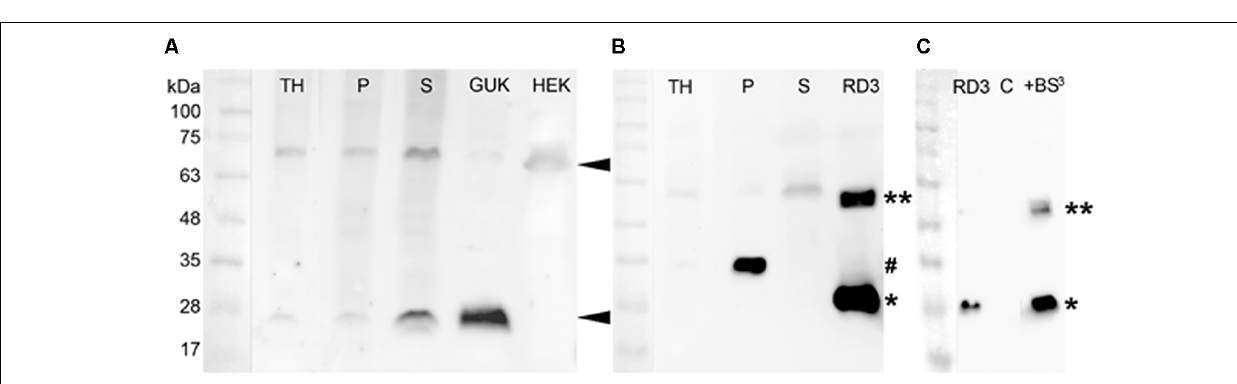
FIGURE 4 | Detection of GUK and RD3 in mouse retina tissue by specific antibodies and RD3 crosslinking. (A) Primary anti-GUK antibody (diluted 1:1000) was tested on mouse retina fractions (30 µ g total protein amount) and stable GUK expressing HEK-293T cells (15 µ g total protein amount). GUK-immunoreactive proteins are marked (cid:74) . (B) Anti-RD3 antibody (diluted 1:500) was tested on mouse retina fractions (30 µ g) and RD3 expressed in Escherichia coli (1 µ g). RD3-positive proteins in retinal fractions were marked ( # ), as well as the monomeric ( ∗ ) and dimeric ( ∗∗ ) form of purified RD3. TH, total retina homogenate; P, crude retinal membrane faction; S, crude retinal cytosolic fraction (see section “Materials and Methods” for details). (C) For the crosslinking experiment, the same anti-RD3 mouse monoclonal antibody was used (diluted 1:1000). An amount of 0.1 µ g RD3 and 7.5 µ g HEK cell lysate (C = negative control) were used.